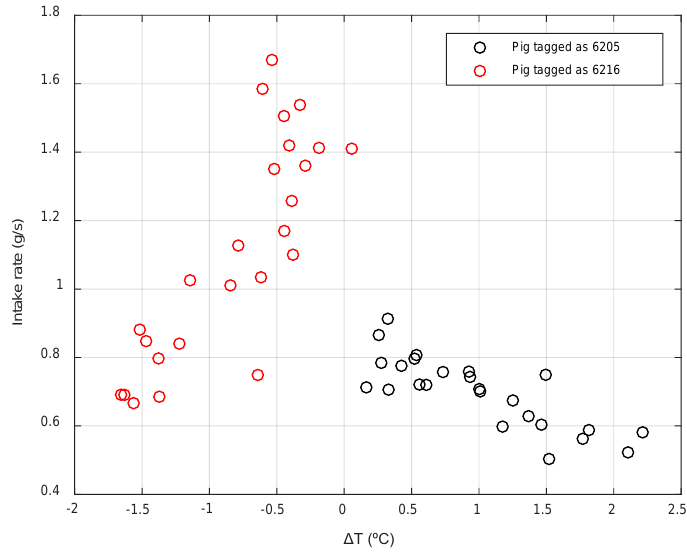
Figure 13. Di ff erences in the individual temperature of animals 6205 and 6216 and the average Figure 13. Differences in the individual temperature of animals 6205 and 6216 and the average temperature of the group ( ∆ T), compared to the intake temperature of the group ( ∆ T), compared to the intake rate.